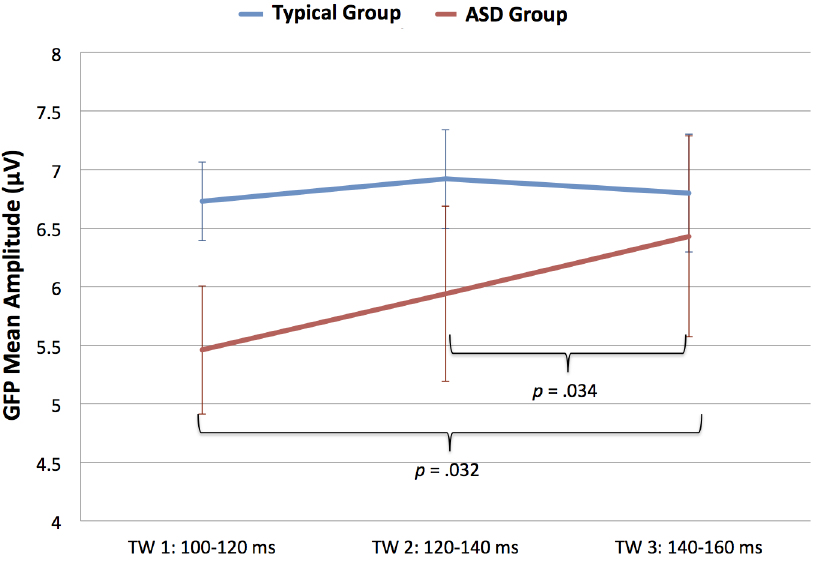
Fig 6. Time Window x Group interaction for auditory GFP. Mean and standard error bars of the GFP to the word (auditory P1 peak) at the three time windows for the two groups.